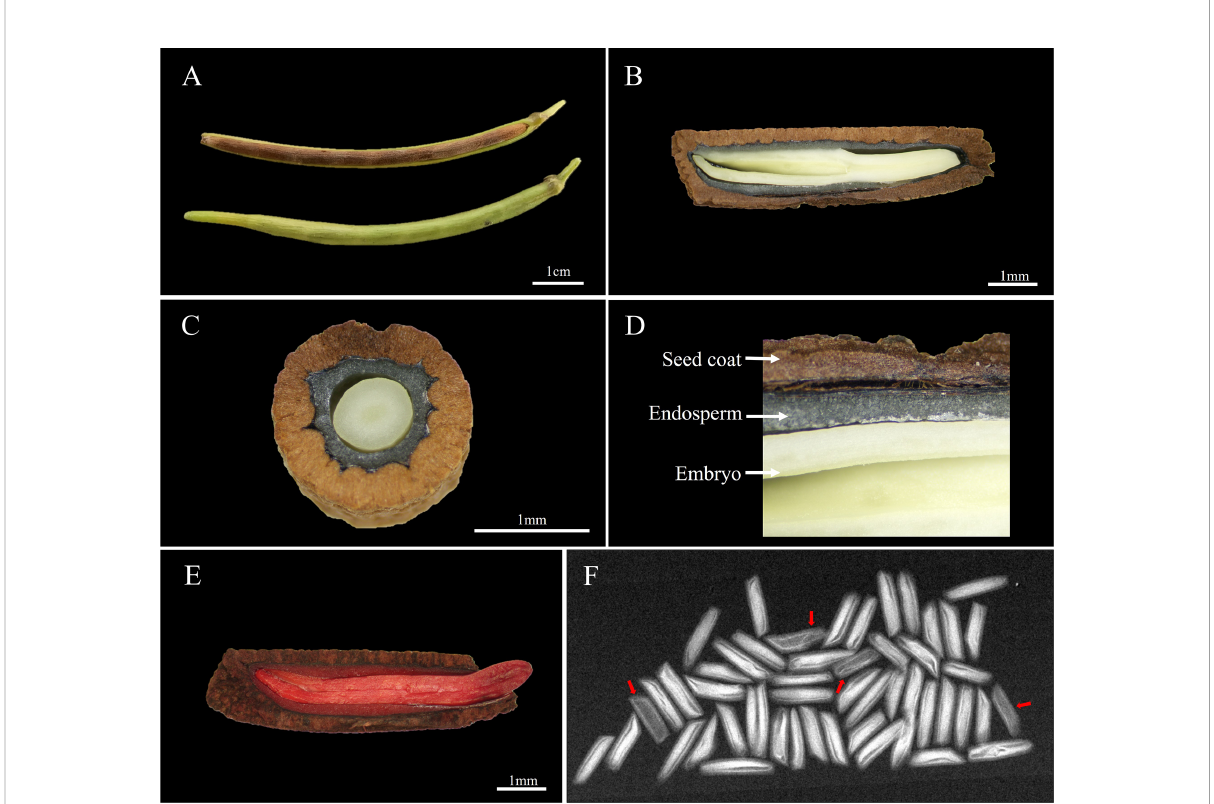
FIGURE 1 Morphological characteristics and viability of Amsonia elliptica seeds. (A) , arrangement of the seeds in the follicle; (B) , longitudinal section of seeds; (C) , horizontal section of seeds; (D) , the internal structure of seeds; (E) , scari fi ed seed after soaking in tetrazolium solution; (F) , Fidelity of seeds con fi rmed by X-ray images. The red arrow represents empty seeds.